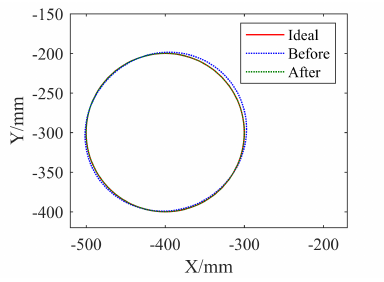
Figure 3. Trajectories of the moving platform: circular case.